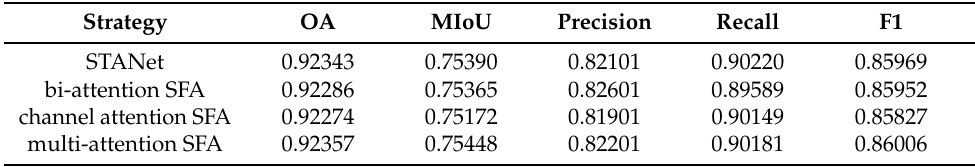
Table 10. The experiment results on the LEVIR-CD dataset with four